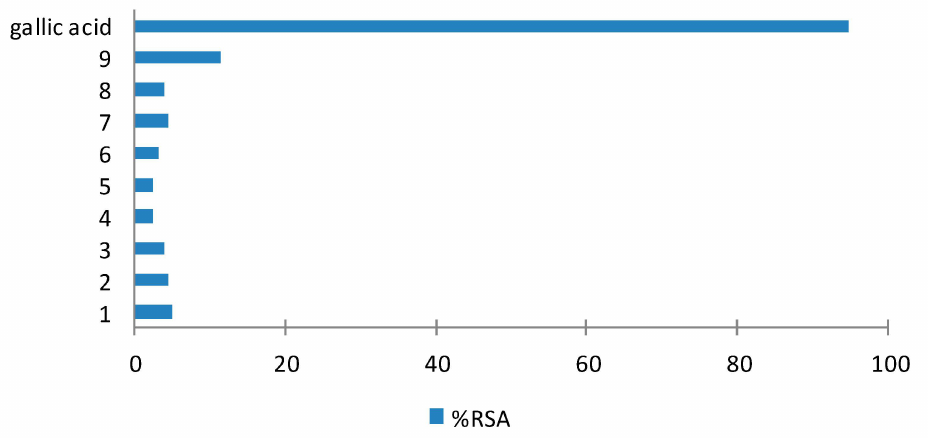
Figure 9. DPPH radical scavenging activity of polymethoxyflavones ( 1 – 9 ) at 25 µ